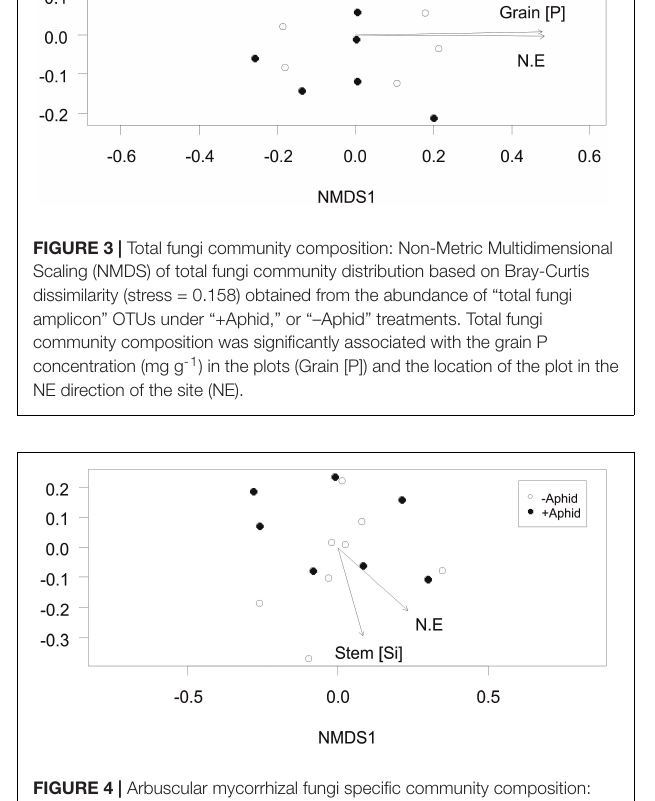
FIGURE 4 | Arbuscular mycorrhizal fungi specific community composition: Non-Metric Multidimensional Scaling (NMDS) of the AMF community distribution based on Bray-Curtis dissimilarity (stress = 0.154) obtained from the abundance of “AMF specific amplicon” VTs under “+Aphid” or “–Aphid” treatments. AMF specific community composition was significantly associated with the barley stem silicon Si (mg g - 1 ) concentration in the plots (Stem [Si]), and the location of the plot in the NE direction of the site (NE